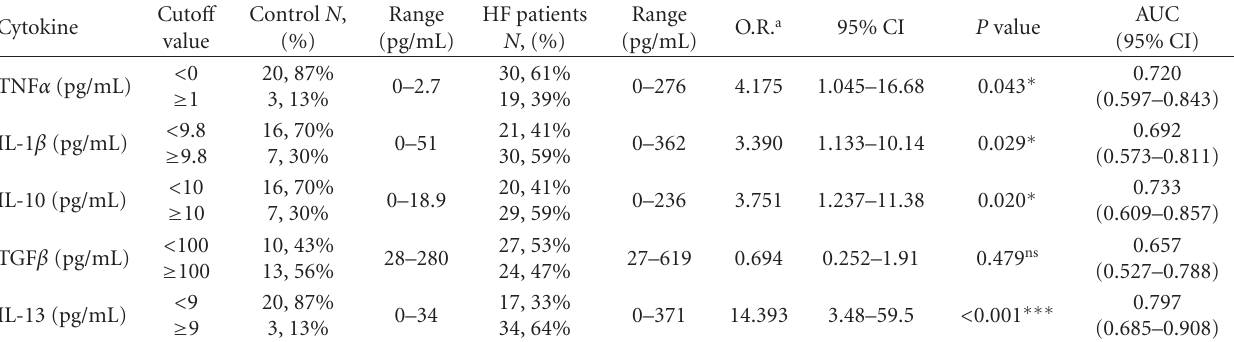
Table 4: Association between serum cytokines and